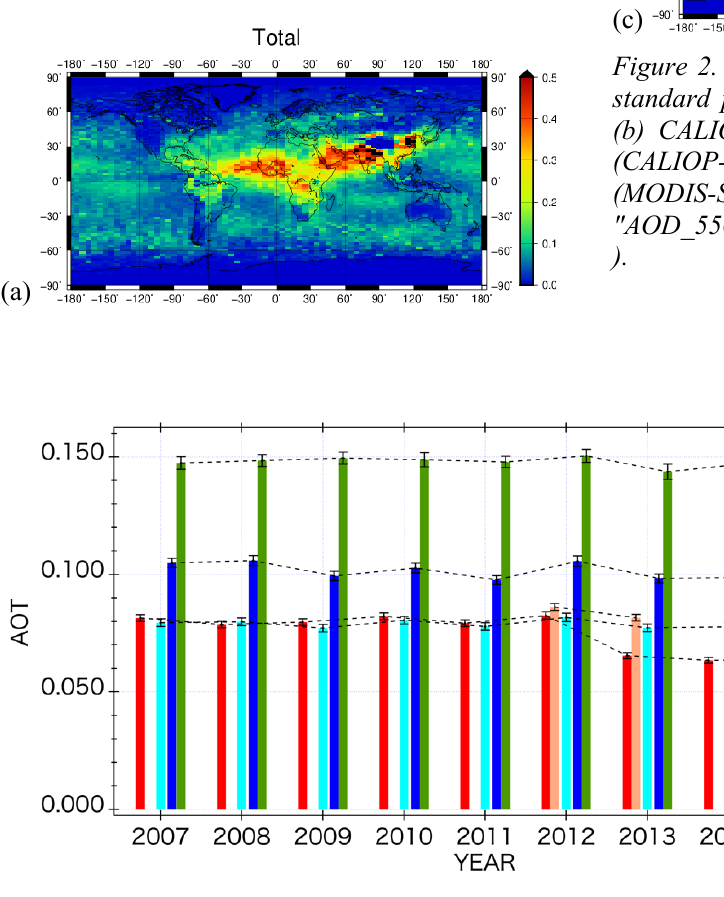
Figure 3. Changes in the annual global AOT average value of each product for 9 years (2007 – 2015, only day-time). Error bars represent standard